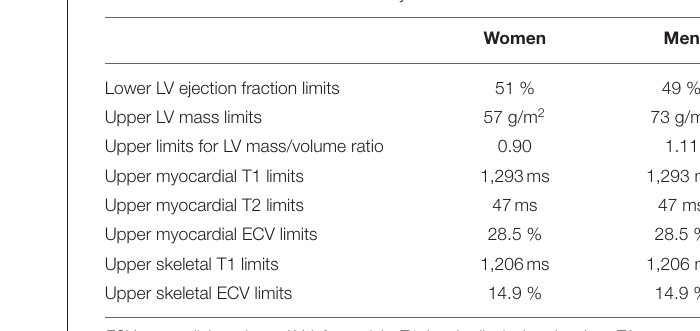
TABLE 1 | Limits used to define abnormal values for the main CMR parameters obtained from local control populations with the same operator and extraction methods as the current COVID-19